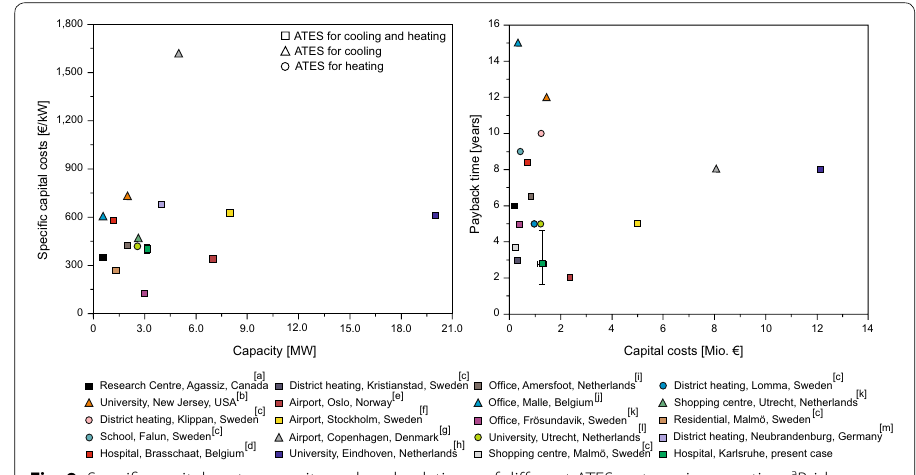
Fig. 9 Specific capital costs, capacity and payback times of different ATES systems in operation. a Bridger and Allen (2010), b Paksoy et al. (2009), c Andersson and Sellberg (1992), d Vanhoudt et al. (2011), e Eggen and Vangsnes (2005), f Wigstrand (2009), g Baxter et al. (2018), h Worthington (2011), i Dincer and Rosen (2011), j Hoes et al. (2006), k Bakema et al. (1994), l Sanner